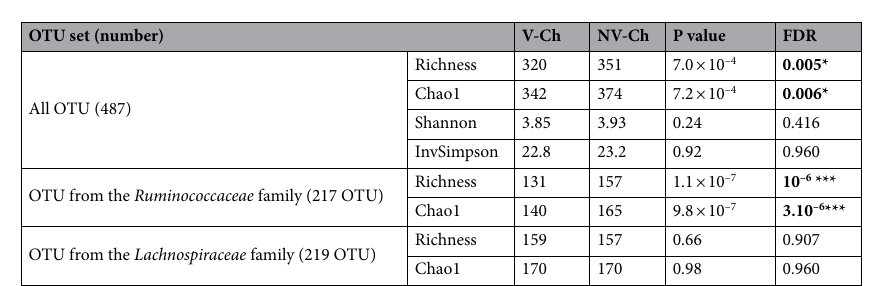
Table 1. Effect of IBV vaccination on the α-diversity of the caecal microbial community of 9-week-old hens, one week after their infection with IBV. α-diversity indices among the vaccinated and challenged (V-Ch) and the non-vaccinated and challenged (NV-Ch) groups, with the richness index representing the number of observed OTU. The vaccination effect is first described in the total bacterial community (first line ‘All OTU’) and then within the Ruminococcaceae (second line) and Lachnospiraceae (third line) families separately. We indicated the mean of each alpha-diversity indices in the V-Ch NV-Ch groups, and set the FDR of the vaccination effect in bold letter when significant (*< 0.05, and ***< 0.001). Alpha diversity indices are available in Supplementary Table S5.